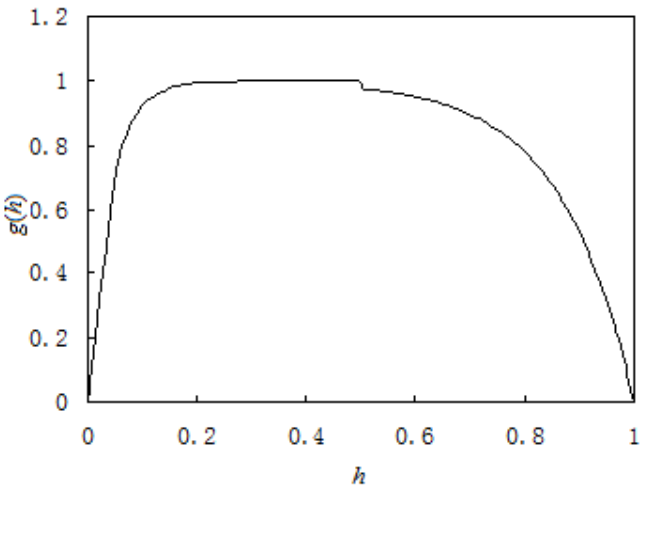
Figure 5. The relationship between h and g ( h ) which is given in Equations (46) and (47). h is equal to the thickness of martensite lamella/(the thickness of martensite lamella + the thickness of austenite lamella), which stands for relative